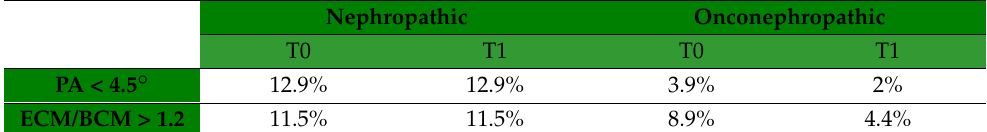
Table 4. Percentage of malnourished individuals in the two population groups. Cut-off values were taken from the literature: PA < 4.5 ◦ as a cut-off for protein-energy wasting in stage V non-dialysis CKD patients [33], ECM/BCM > 1.2 as an indicator of wasting and fluid overload in hemodialysis patients [34].